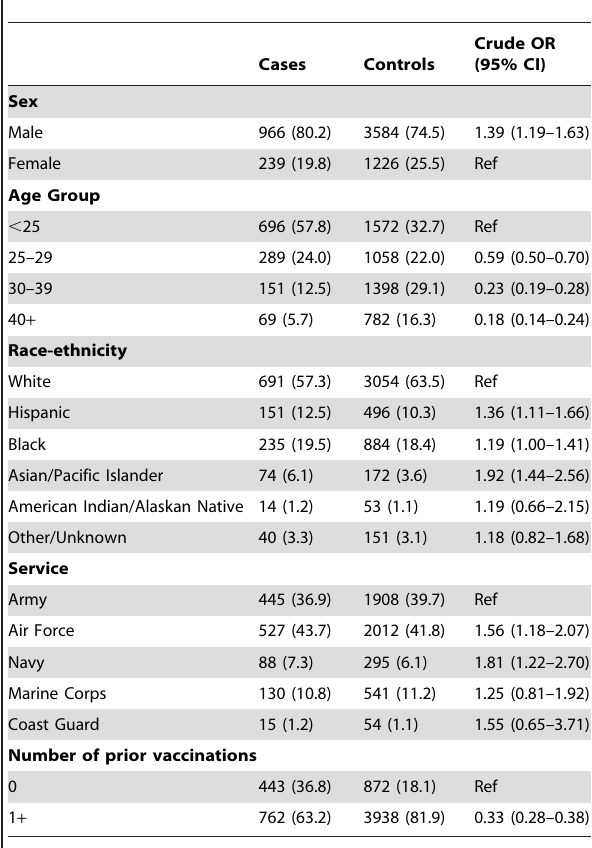
Table 1. Univariate Analysis and Characteristics of pH1N1 Cases and Controls.